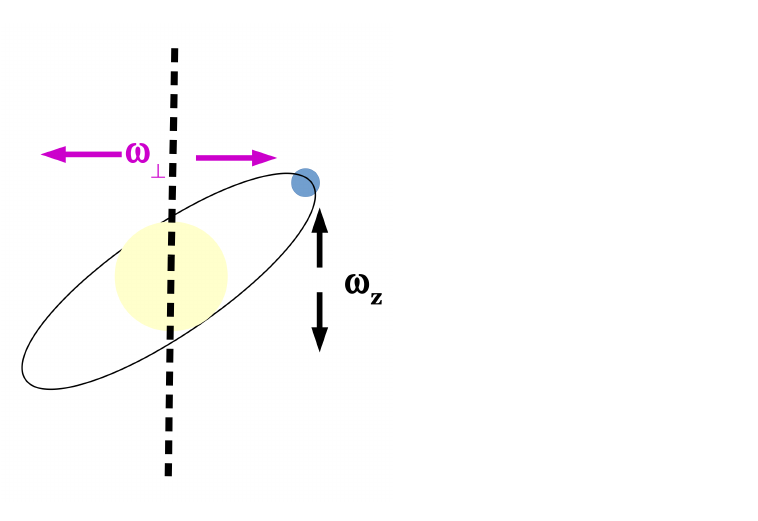
Figure 6. The generic motion of a satellite bound to the galaxy but off its disk’s plane is not planar: the instantaneous orbital plane precesses around the cylinder. It can be seen by noting that the angular frequency of vertical motion ω z coincides with that of the Newtonian problem, consistently with the translational invariance of the filament, but the oscillation angular frequency ω ⊥ in the orbital plane differs due to the part of the force caused by G λ